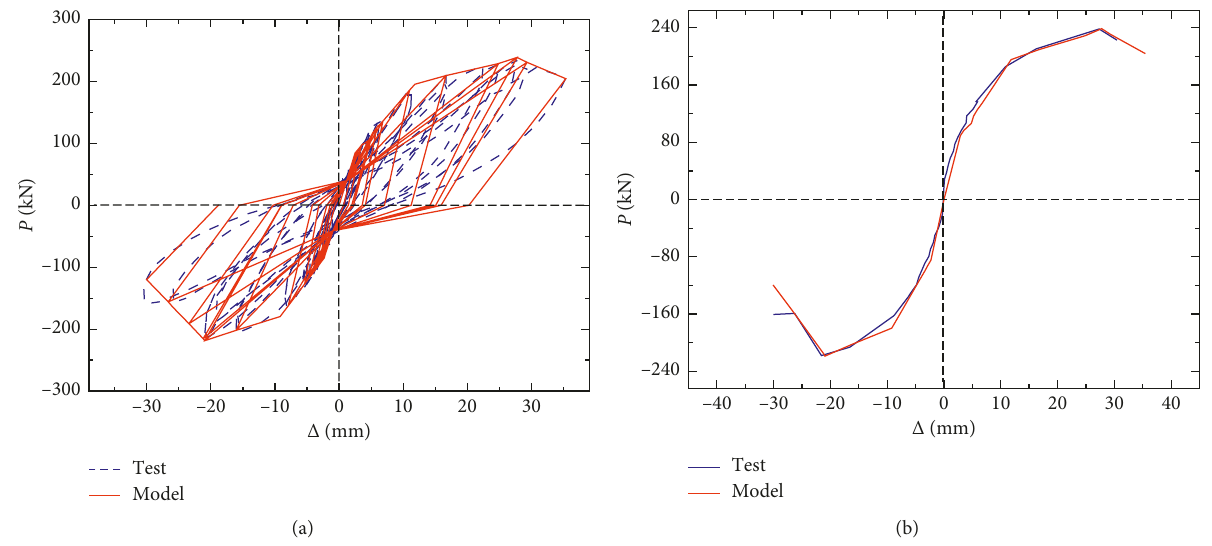
Figure 13: Comparison of the restoring force model and test results of specimen S2: (a) hysteretic curves; (b)